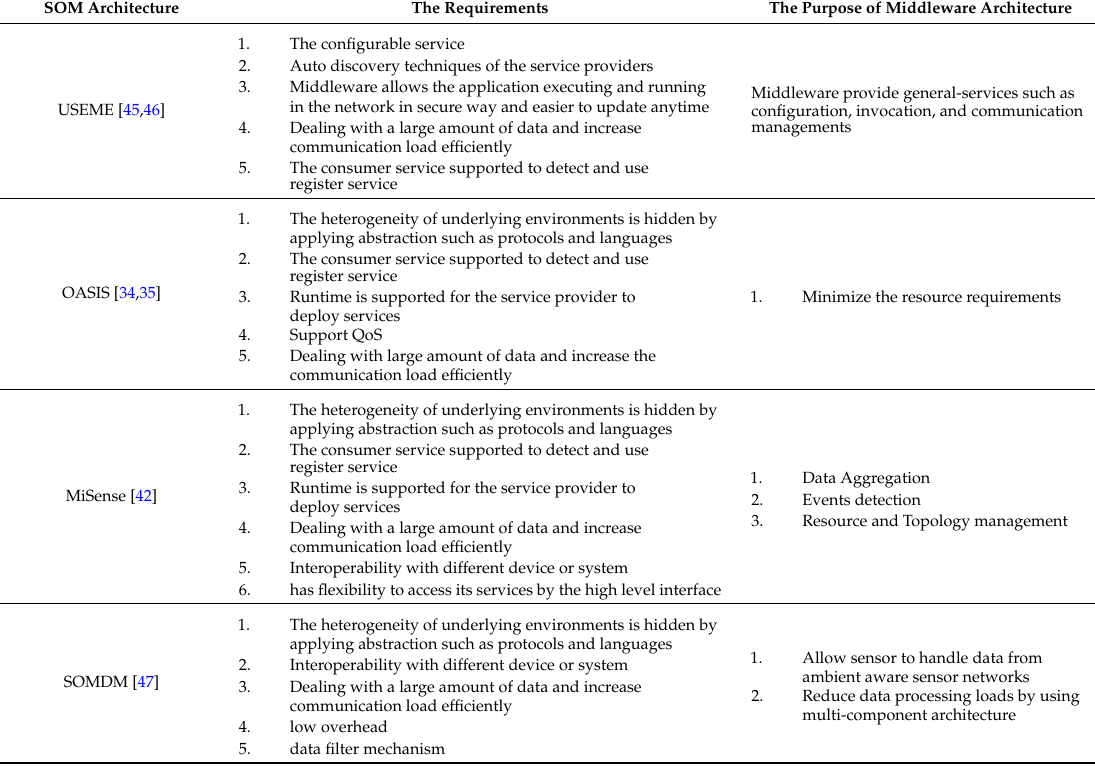
Table 4. The Requirements and Benefits of Using Middleware Architectures for